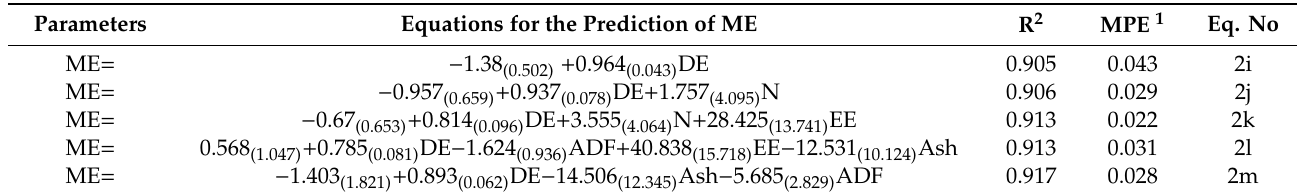
Table 4. Prediction equations for herbage ME concentration using DE concentration and chemical composition